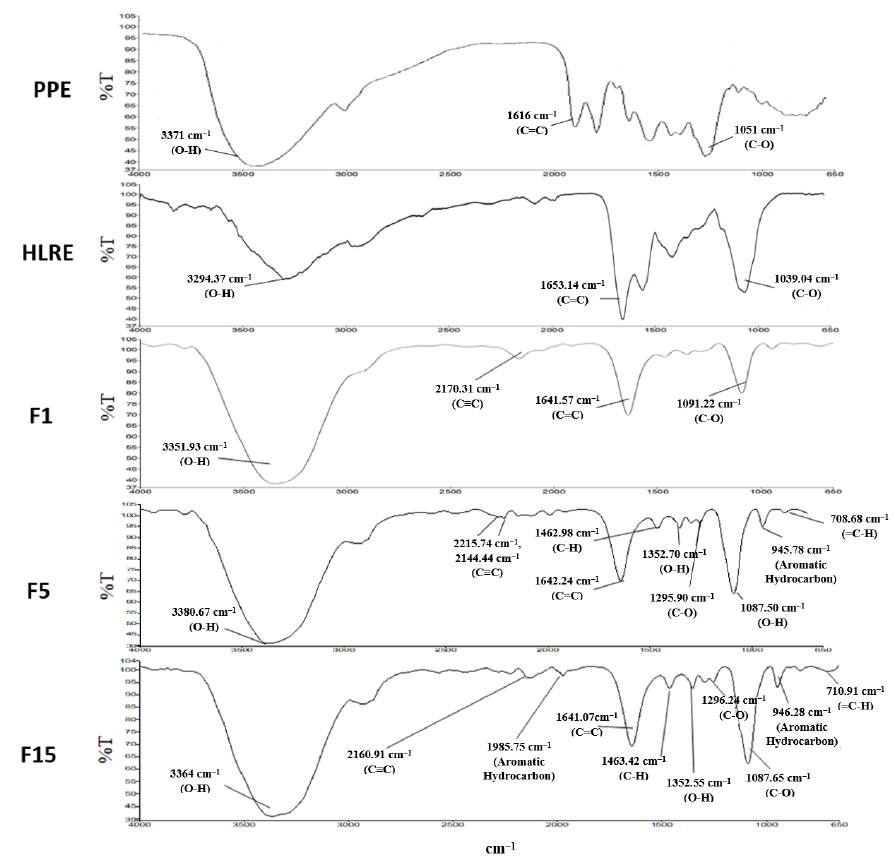
Gels 2023 , 9 , x FOR PEER REVIEW Figure 3. FTIR of PPE, HLRE, F1, F5, and F15. Figure 3. FTIR of PPE, HLRE, F1, F5, and F15.